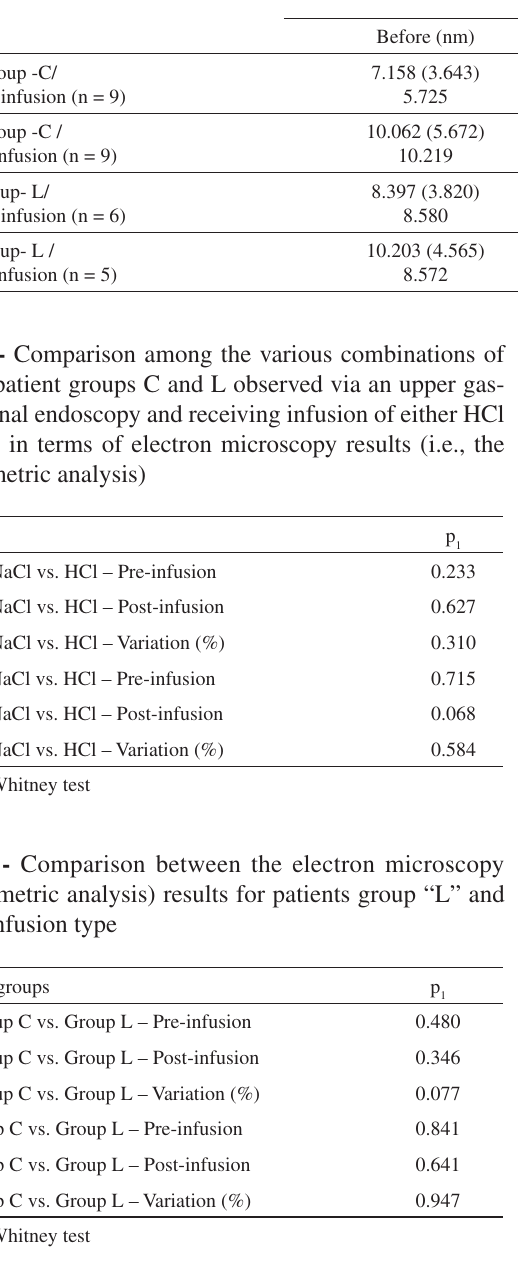
Table 1 - Electron microscopy results showing pre-infusion values, post-infusion values and variations between the two Group Control Group -C/ With NaCl infusion (n = 9)